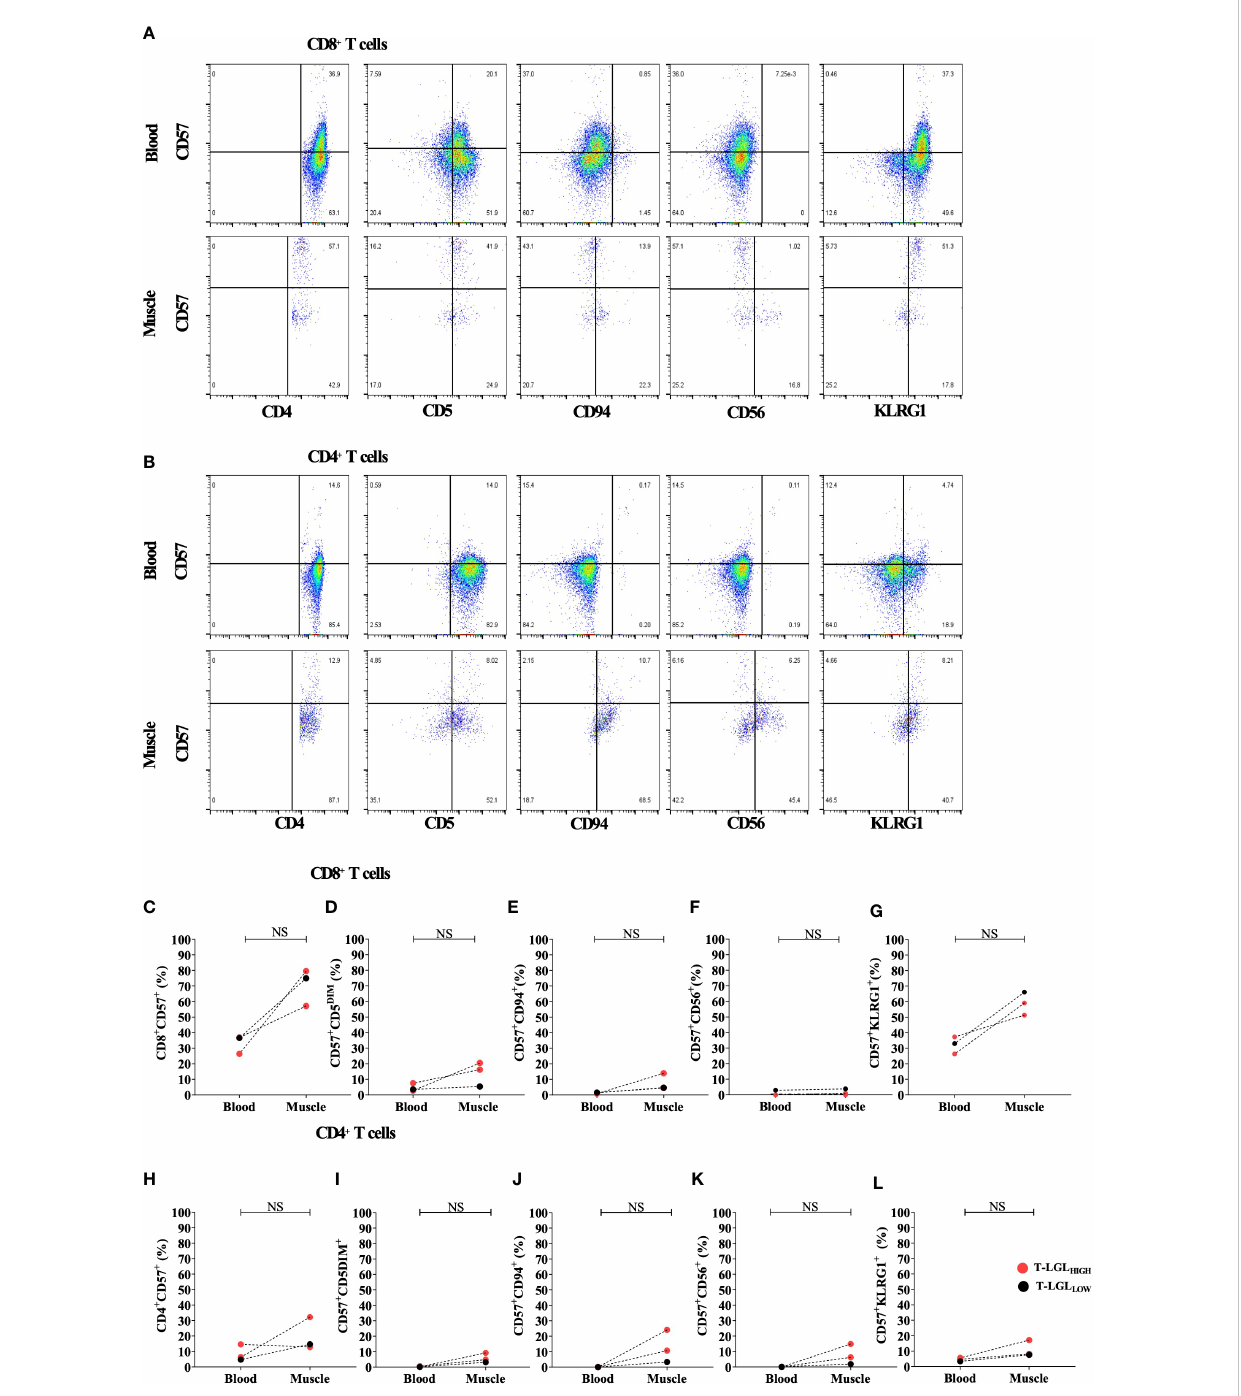
FIGURE 6 Comparison of CD8 + and CD4 + T cell phenotype in blood and muscle. Representative Flow cytometry plots gated on (A) and CD4 + T cells (B) . Comparison of the proportion in blood and muscle of CD57 + in CD8 + (C) and CD4 + (H) T cells, and of CD5 DIM , CD94 + , CD56 + and KLRG1 + in CD8 + CD57 + (D – G) and in CD4 + CD57 + (I – L) cells. Statistical analysis was performed using one-tailed Wilcoxon matched pairs signed rank test T-LGL HIGH n=2, T-LGL LOW n=1). NS, Not Signi fi